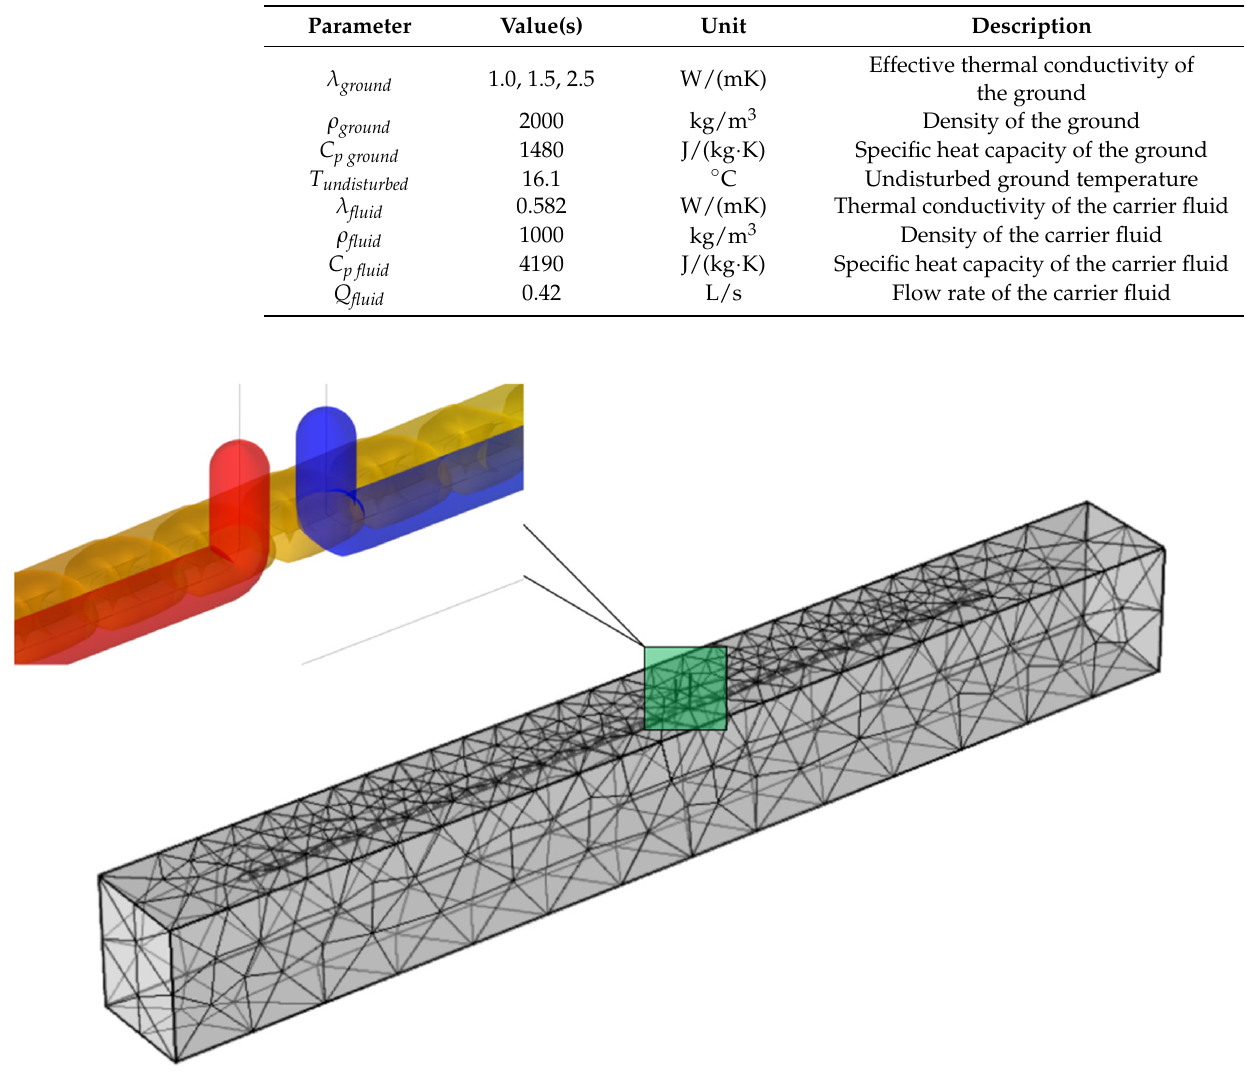
Table 2. Material properties.